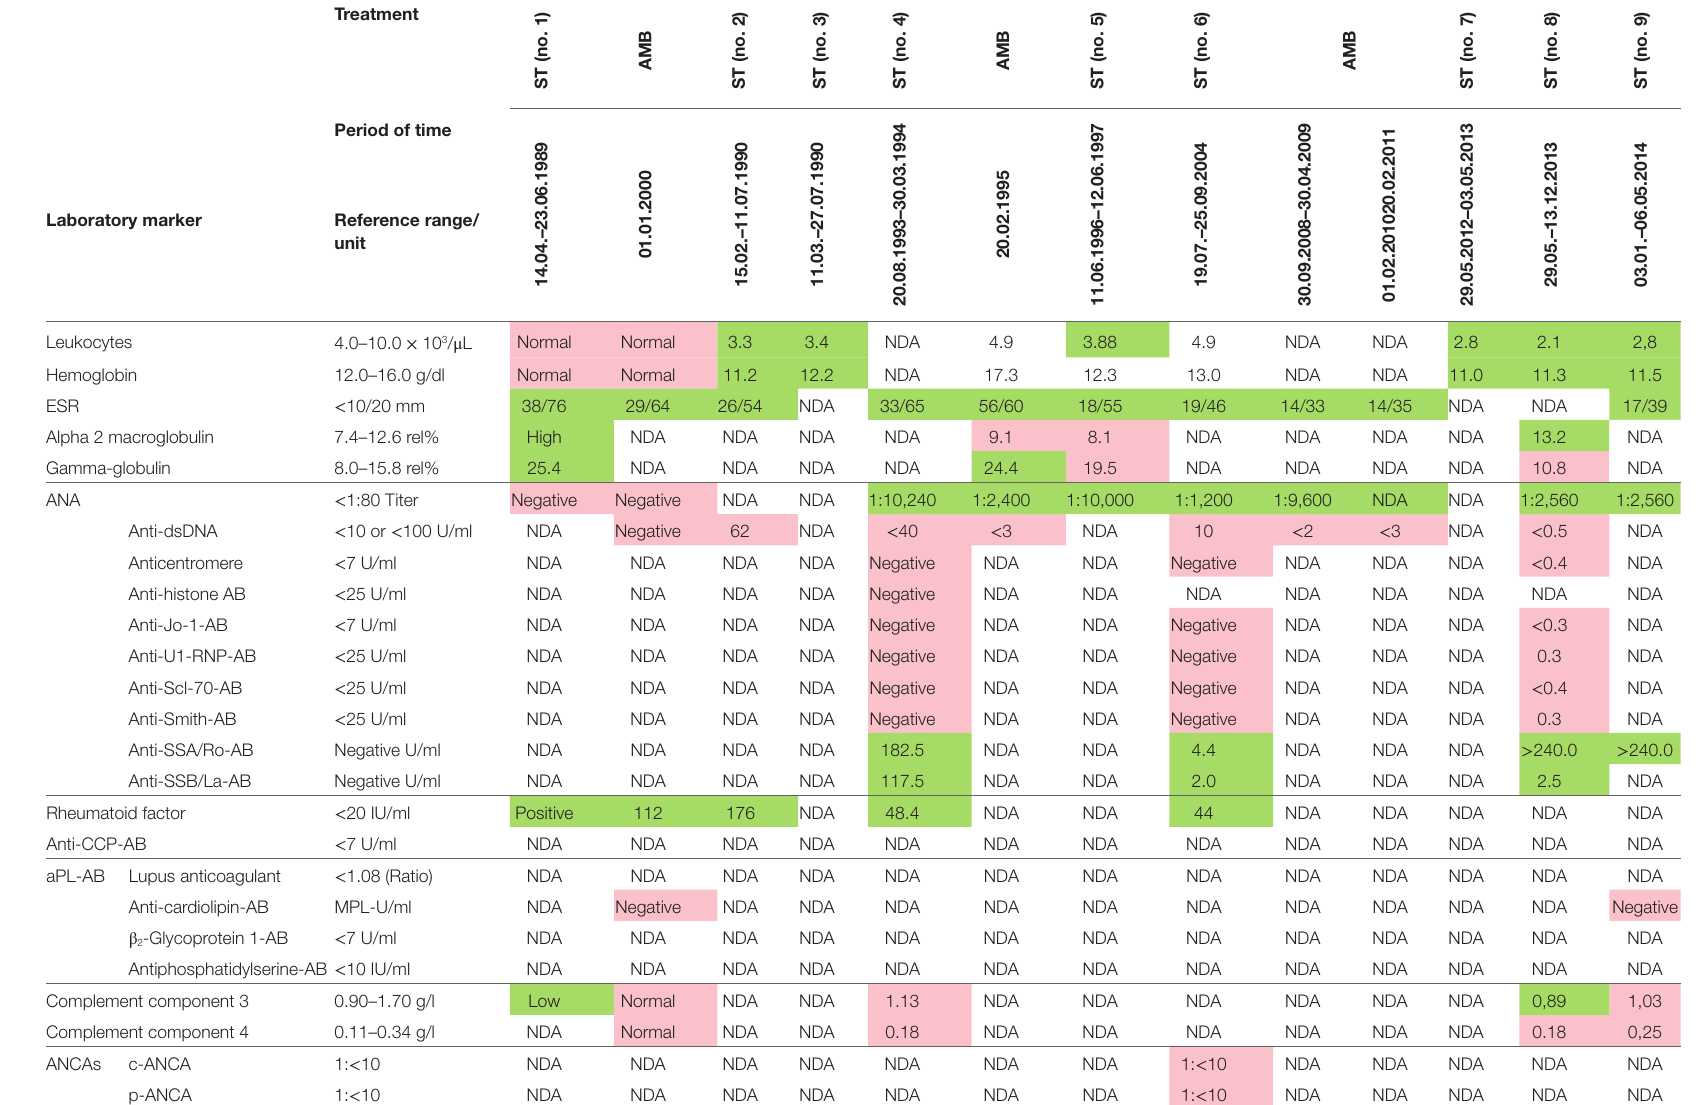
taBLe 1 | Exemplary serological immunoinflammatory markers of the patient over last 25